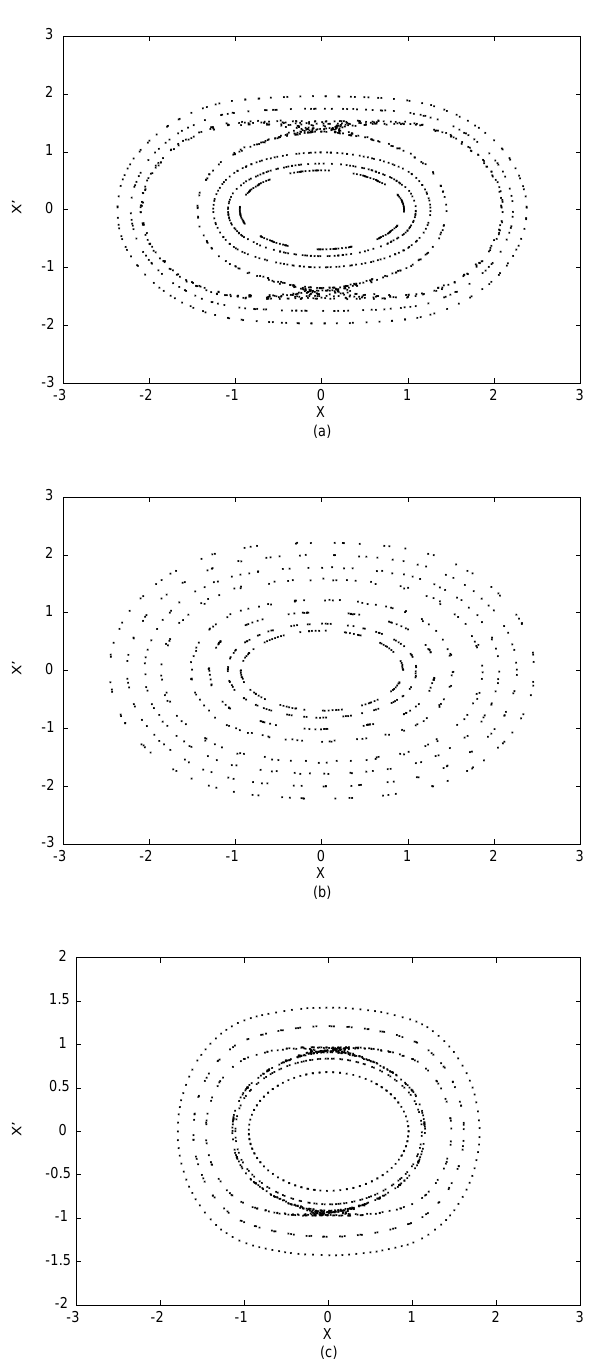
FIG. 10. The stroboscopic plot in the X - X 0 plane under (a) the high mode, (b) the low mode, and (c) the quadrupole mode with a 5% initial transverse mismatch, with focusing strength ratio k z 0 (cid:1) k x 0 (cid:1) 0.634 .